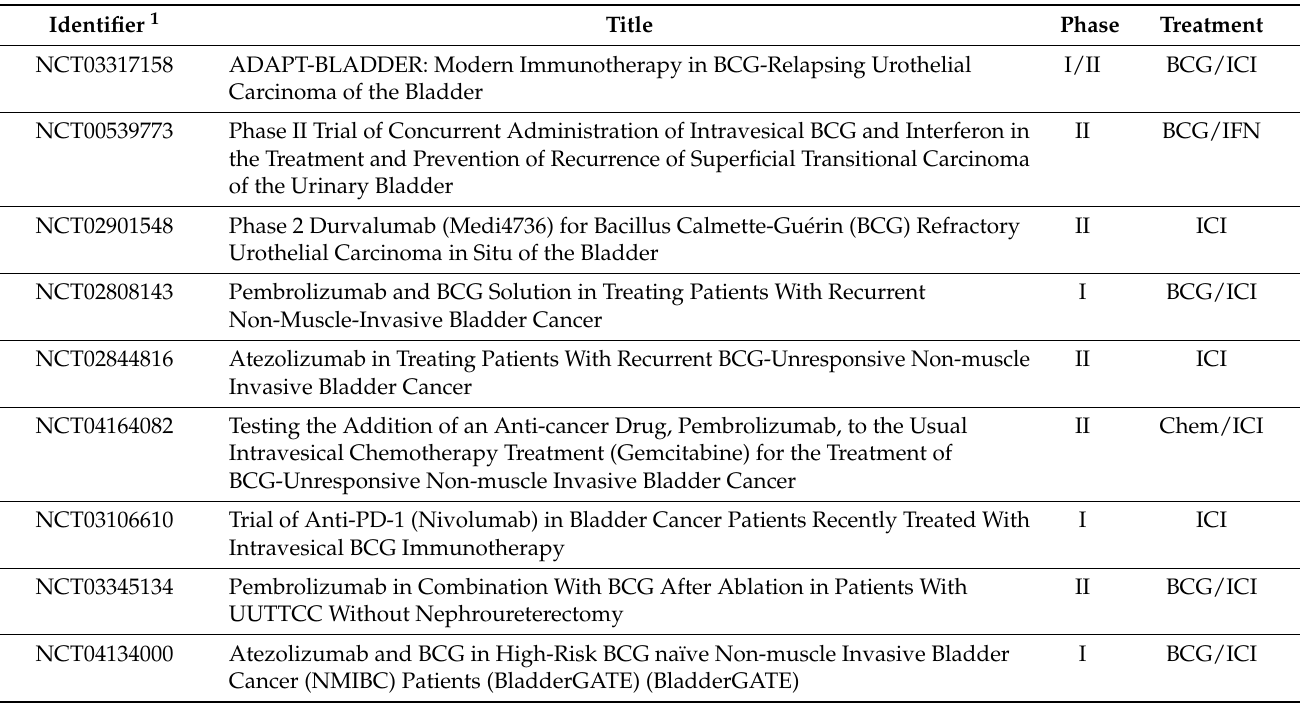
Table 1. Clinical trials evaluating ICIs in relation to BCG for NMIBC